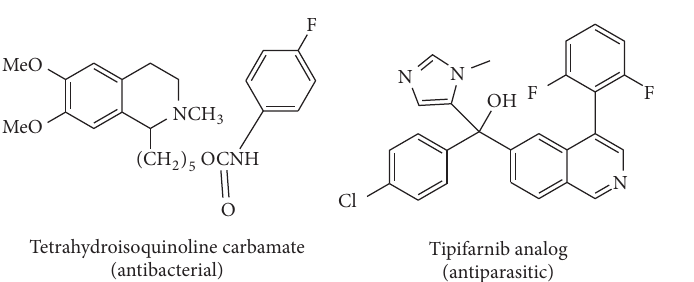
cycloaddition of benzonitriles 8 and 9 to prepare the 1-amino- isoquinolines 10a - b which are fluorinated at the 6- and 7- positions in moderate yields